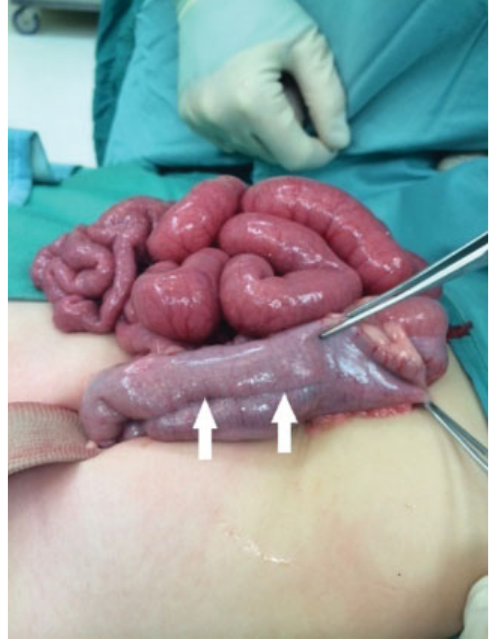
Fig. 6 On laparotomy, the duplicated rectum and colon shared a common wall (arrows).